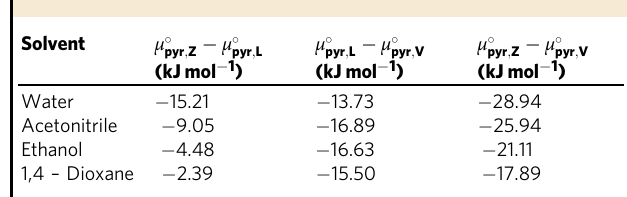
Fig. 2 Adsorption of pyridine on siliceous porous materials in liquid water. a Pyridine adsorption isotherms on adsorbents of varying average pore diameters in liquid water in ATR-FTIR at 20 °C. The pore-phase pyridine concentration on MAS is denoted by “ + ” signs and the pyridinium is denoted by dots. The sum of the pyridine on BAS and MAS is denoted with a dashed line for H/USY. b The pore-phase pyridine concentration with 0.1 M pyridine in the external solvent as a function of pore diameter. The ATR-FTIR spectra for the data in Fig. 2 can be found in Supplementary Figs. 26-31. Note that aluminosilicate FAU is used because siliceous FAU cannot be synthesized. Inset: depiction of the adsorbent pore diameter ( d p ). c Depiction of pyridine adsorption in micropores and mesopores where molecules of identical color experience similar adsorption energetics. Table 1 Henry ’ s Law standard-state chemical potential differences in Si/Beta at 20 °C and 1